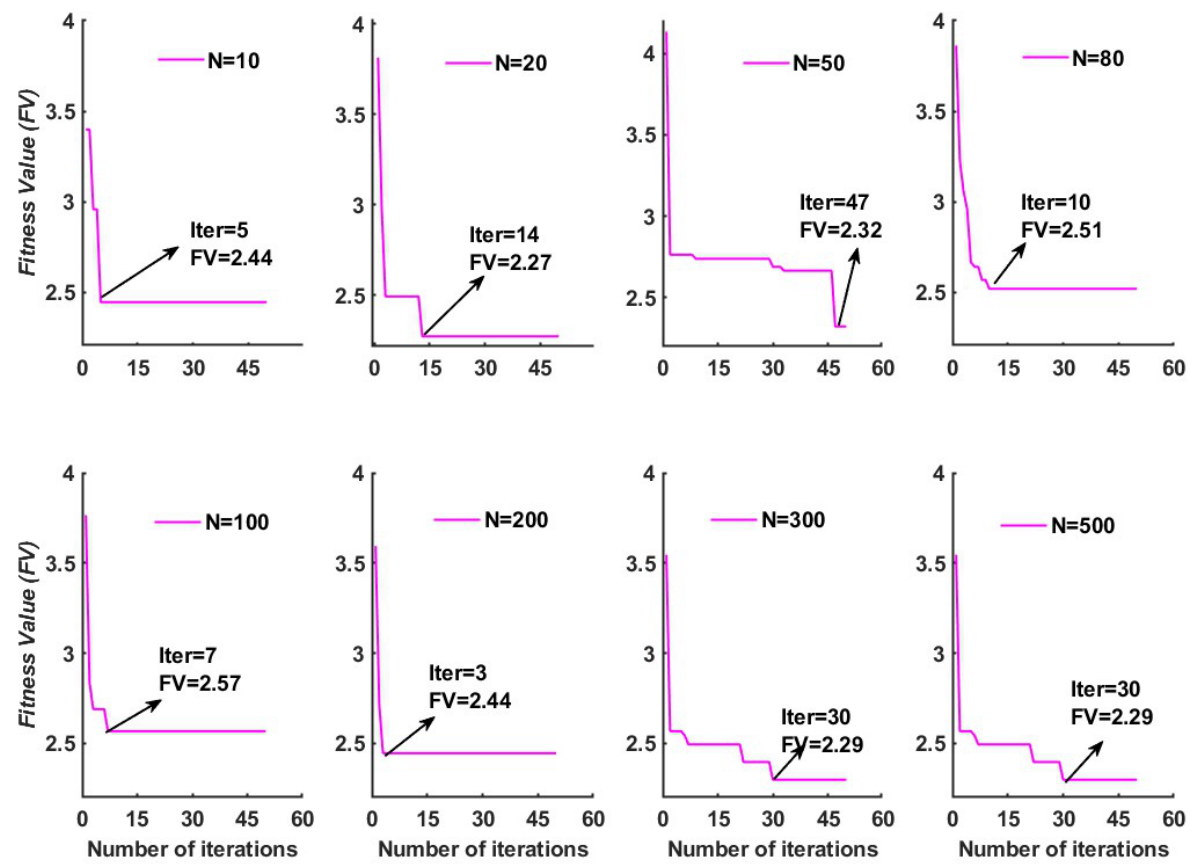
Figure 4. Convergence curves for MRFO feature selection on the predictors for the case of Broadlea solar energy